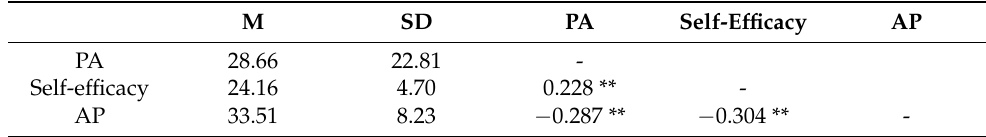
Table 3. Correlations of PA, self-efficacy, and AP.